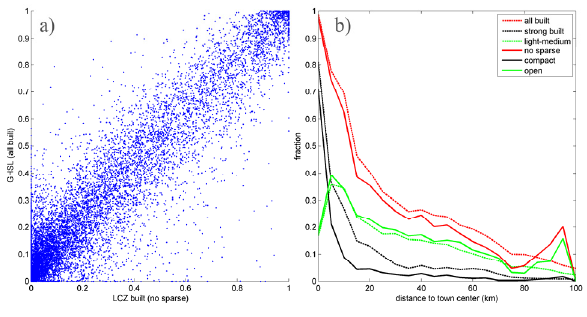
Figure 4. Left: Scatterplot between fraction of LABEL set all built and LCZ set built (without sparse). Right: mean radial fraction by distance from city centre for LABEL sets all built, strong built, light-medium and LCZ sets no sparse, compact , and open .